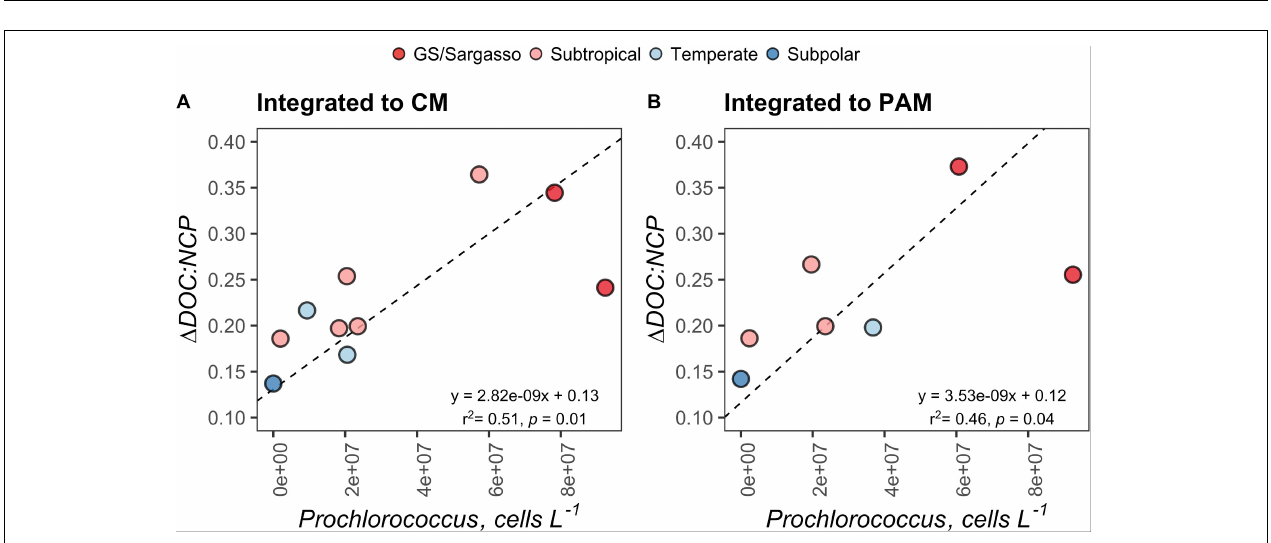
FIGURE 7 | Model regressions comparing the (cid:49) DOC:NCP in the surface 100 m; (A) model regression for the (cid:49) SiO 4 : (cid:49) NO 3 ratio versus latitude and (B) standard major axis model II regression for (cid:49) DOC : NCP versus (cid:49) SiO 4 : (cid:49) NO 3 ratio. Each point represents estimates for a station on the early autumn cruise. Points are filled by the subregional classification of the station as presented in Figure 1 .